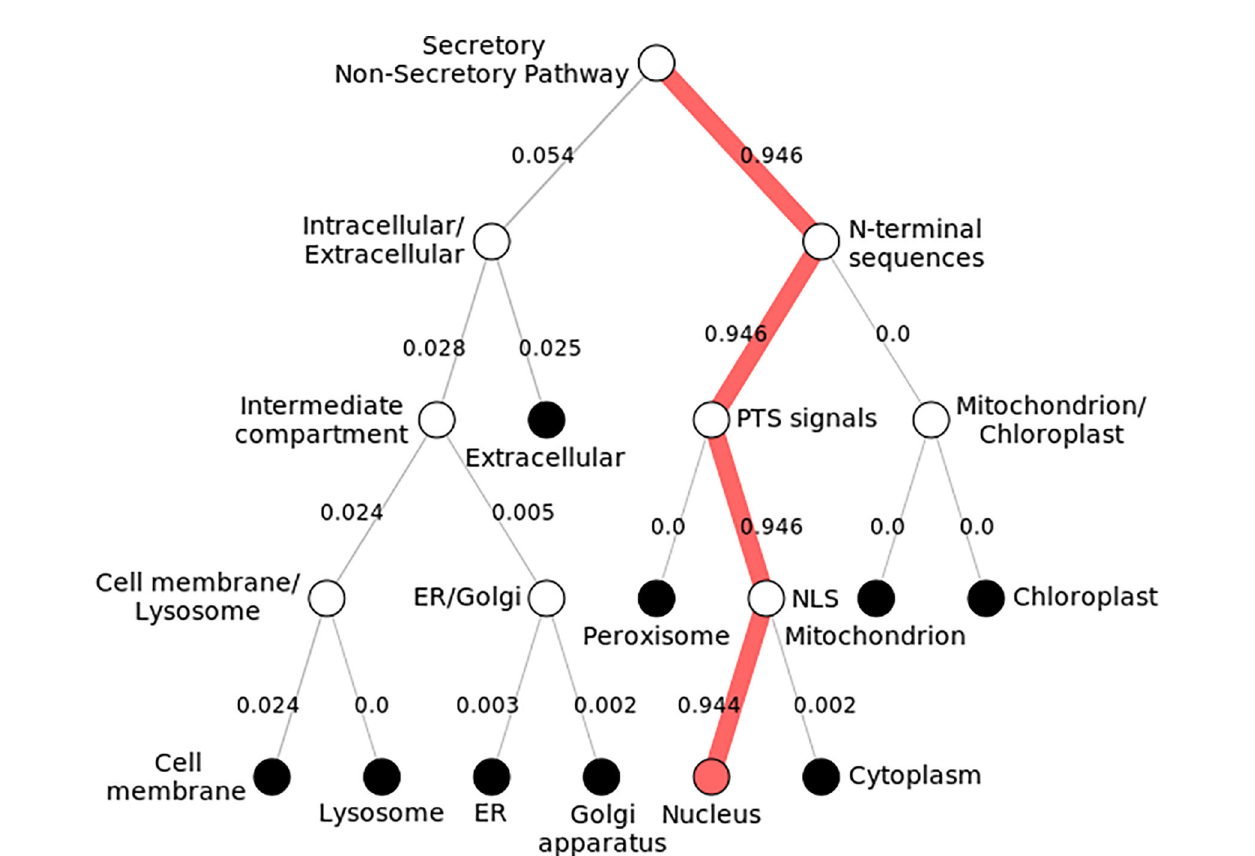
FIGURE 4 | Subcellular localization of KLF9. Pathway following subcellular localization of KLF9 generated by DeepLoc-1.0. Numerous locations are shown, and each follows a distinct pathway and score. The KLF9 protein is localized inside the nucleus (depicted by 0.9 score). It directs toward the nucleus by executing peroxisomal targeting signals (PTS) and nuclear localization signals